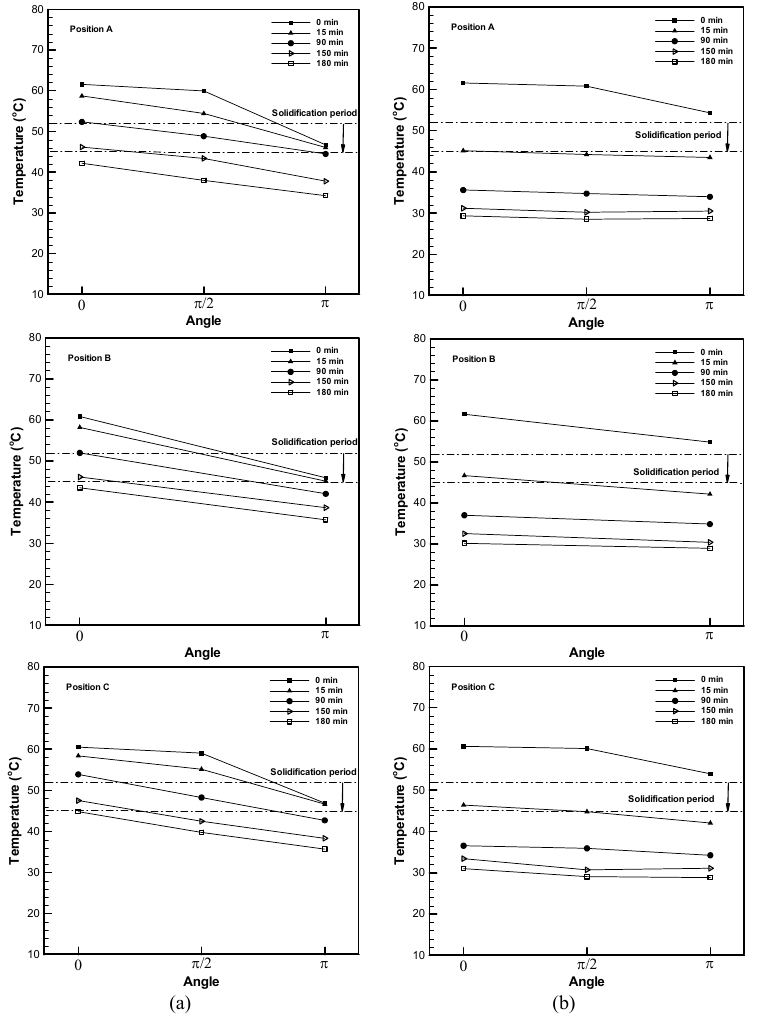
Figure 9. Experimental results of temperature distribution for 13mm height fins heat exchanger for different angles during discharging process for Ste = 0.26: (a) 32.5mm radial distance and (b) 12.5mm radial